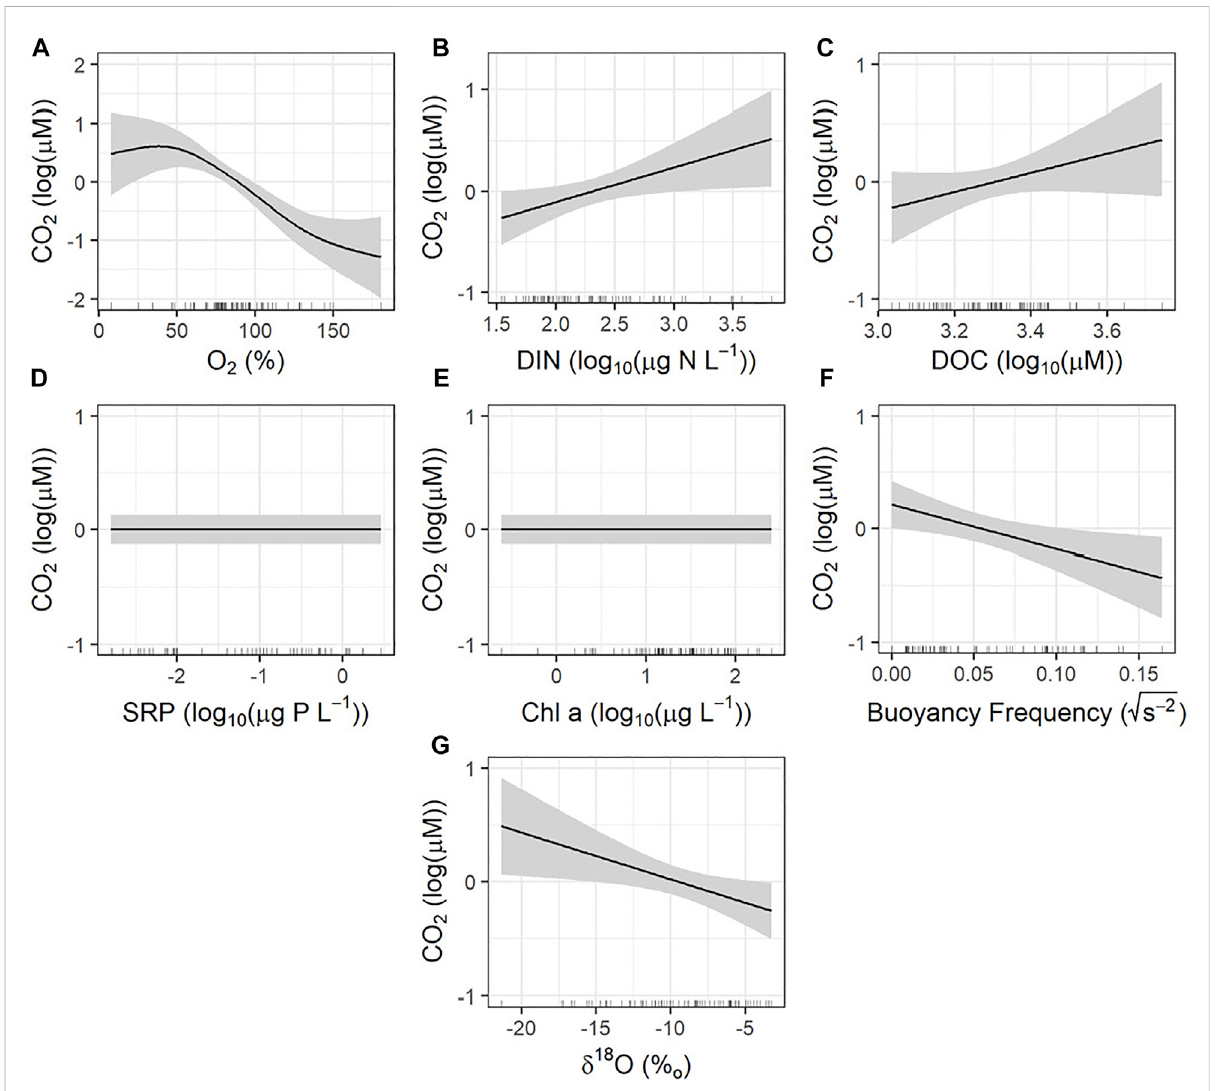
FIGURE 4 Partial effects plots from generalized additive models assessing the seasonal controls of carbon dioxide (CO 2 ). Model deviance explained was 63.9%. Shaded region represents the 95% con fi dence interval. The rug along the x -axis indicates the distribution of observations. (A) Dissolved oxygen saturations; signi fi cant. (B) Dissolved inorganic nitrogen concentration; signi fi cant. (C) Dissolved organic carbon concentration; signi fi cant. (D) Soluble reactive phosphorus concentration; not signi fi cant. (E) Chl- a concentration; not signi fi cant. (F) Buoyancy frequency (strati fi